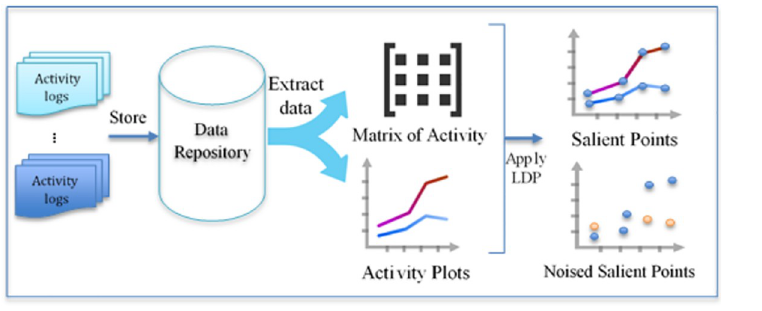
Fig 2. An overview of applying LDP to collected data.